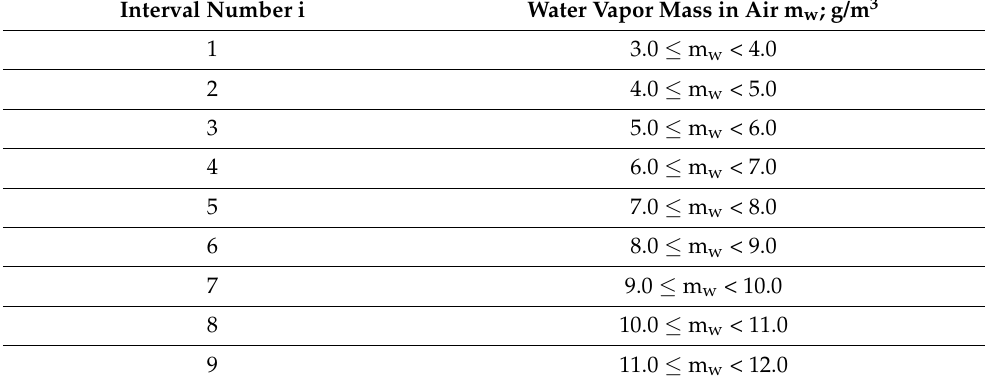
Table 1. The intervals of water vapor